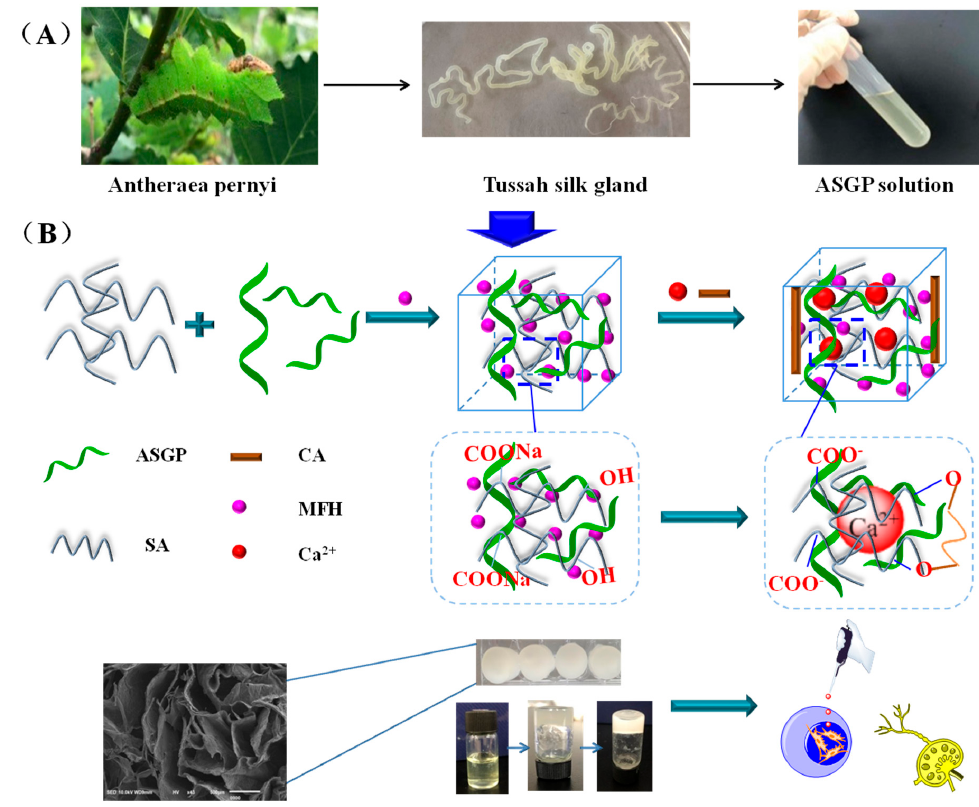
Figure 6. Schematic illustration of the ( A ) extraction of ASGP; ( B ) preparation of drug − loaded hydrogels.